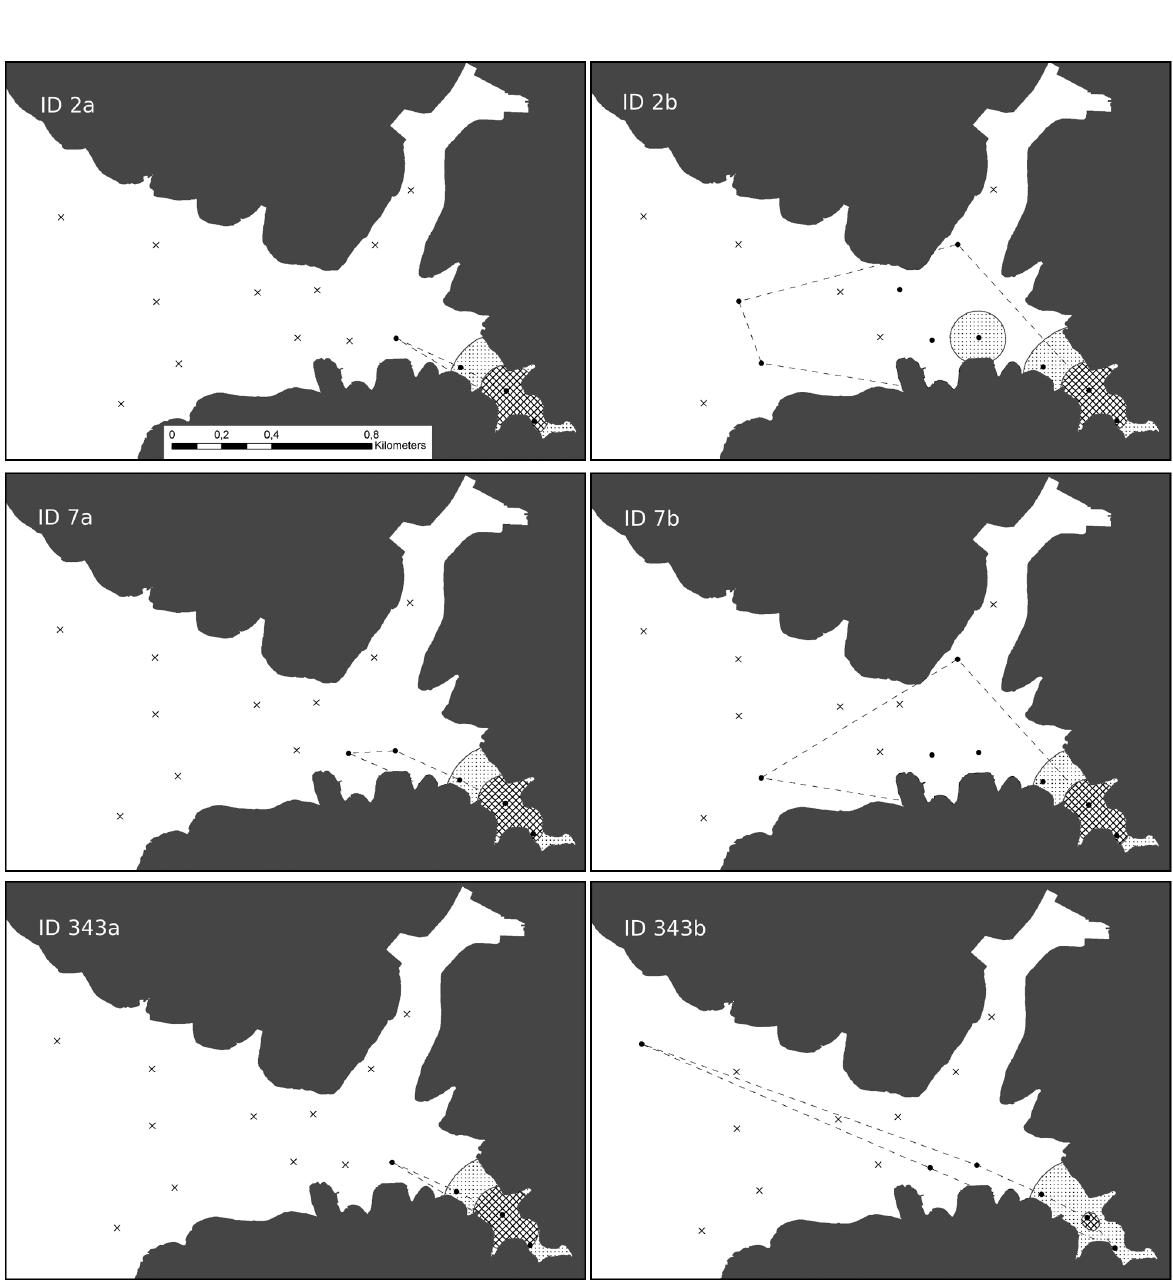
Fig. 4. Home range and core activity areas for acoustically tagged Sparus aurata (IDs 2, 7, and 343) in (a) initial period (first 2 wk after release) and (b) subsequent period (after the 2nd week until end of fish detection within the study area). Minimum convex polygon (MCP) (dashed line), 50% kernel utilization distribution (KUD) (cross-hatched area), and 95% KUD (dotted area). Receivers with ( d ) and without (×) fish detections. Selected individuals show patterns typical of fish recorded for >1